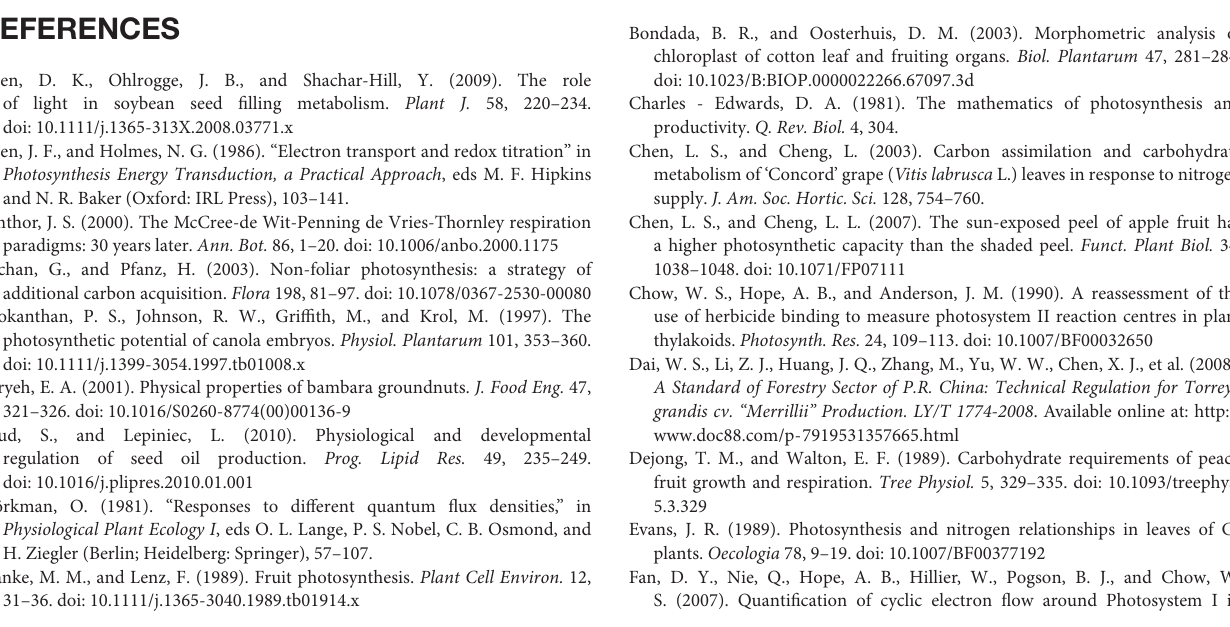
Figure S1 | The standard gas chromatogram of the main fatty acids in seeds of Torreya grandis cv. “Merrillii.” Figure S2 | Light responses of net photosynthesis P n in seeds of Torreya grandis cv. “Merrillii” during seed development; expressed on surface area (A) , dry weight (B) , and single seed (C) basis. For the P n values mean ± SD is indicated. Different letters denote significant differences at P ≤ 0.05 level. n = 4. The light responses were measured on eight dates indicated by the symbols and DASP values in the upper right-hand corner of the uppermost panel. DASP, days after seeds protrusion. Note: The values of P n are negative because of high rates of respiration. The rates were high because the measurements were carried out with intact seed containing also the non-photosynthetic embryo in addition to the photosynthetic sarcotesta. The absolute value of the negative P n indicates the re-fixation by the sarcotesta photosynthesis of the CO 2 released from respiration. See introduction of the main text for further explanation. Table S1 | The inhibitive effect of different concentrations of DCMU on the ETR of seed in comparison with the